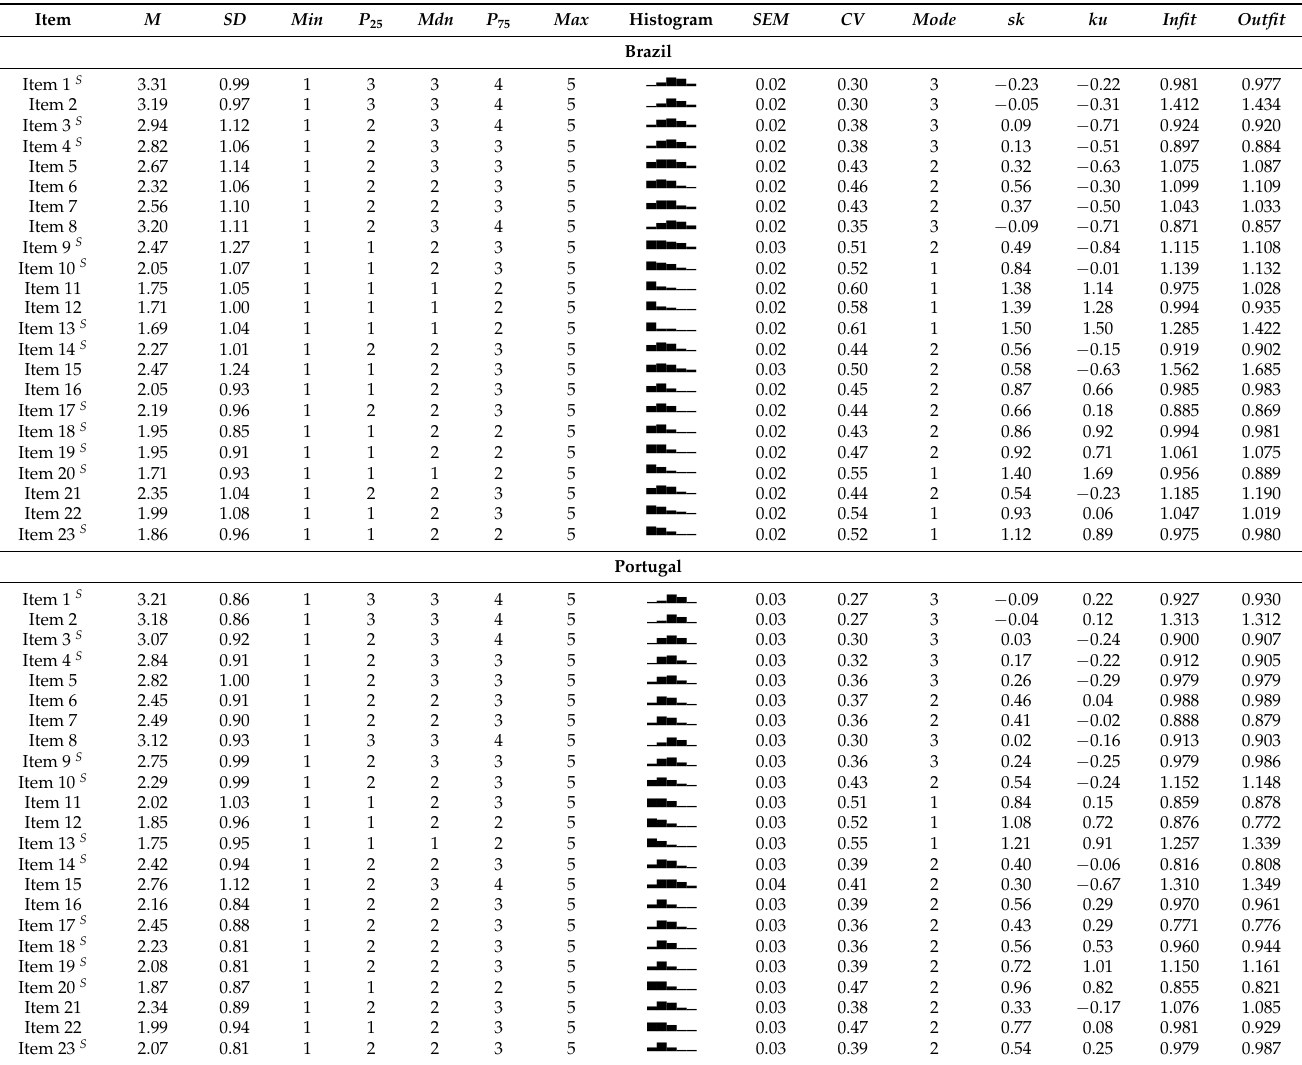
Table 3. BAT items’ infit, outfit statistics, and distributional properties for Portugal and Brazil.